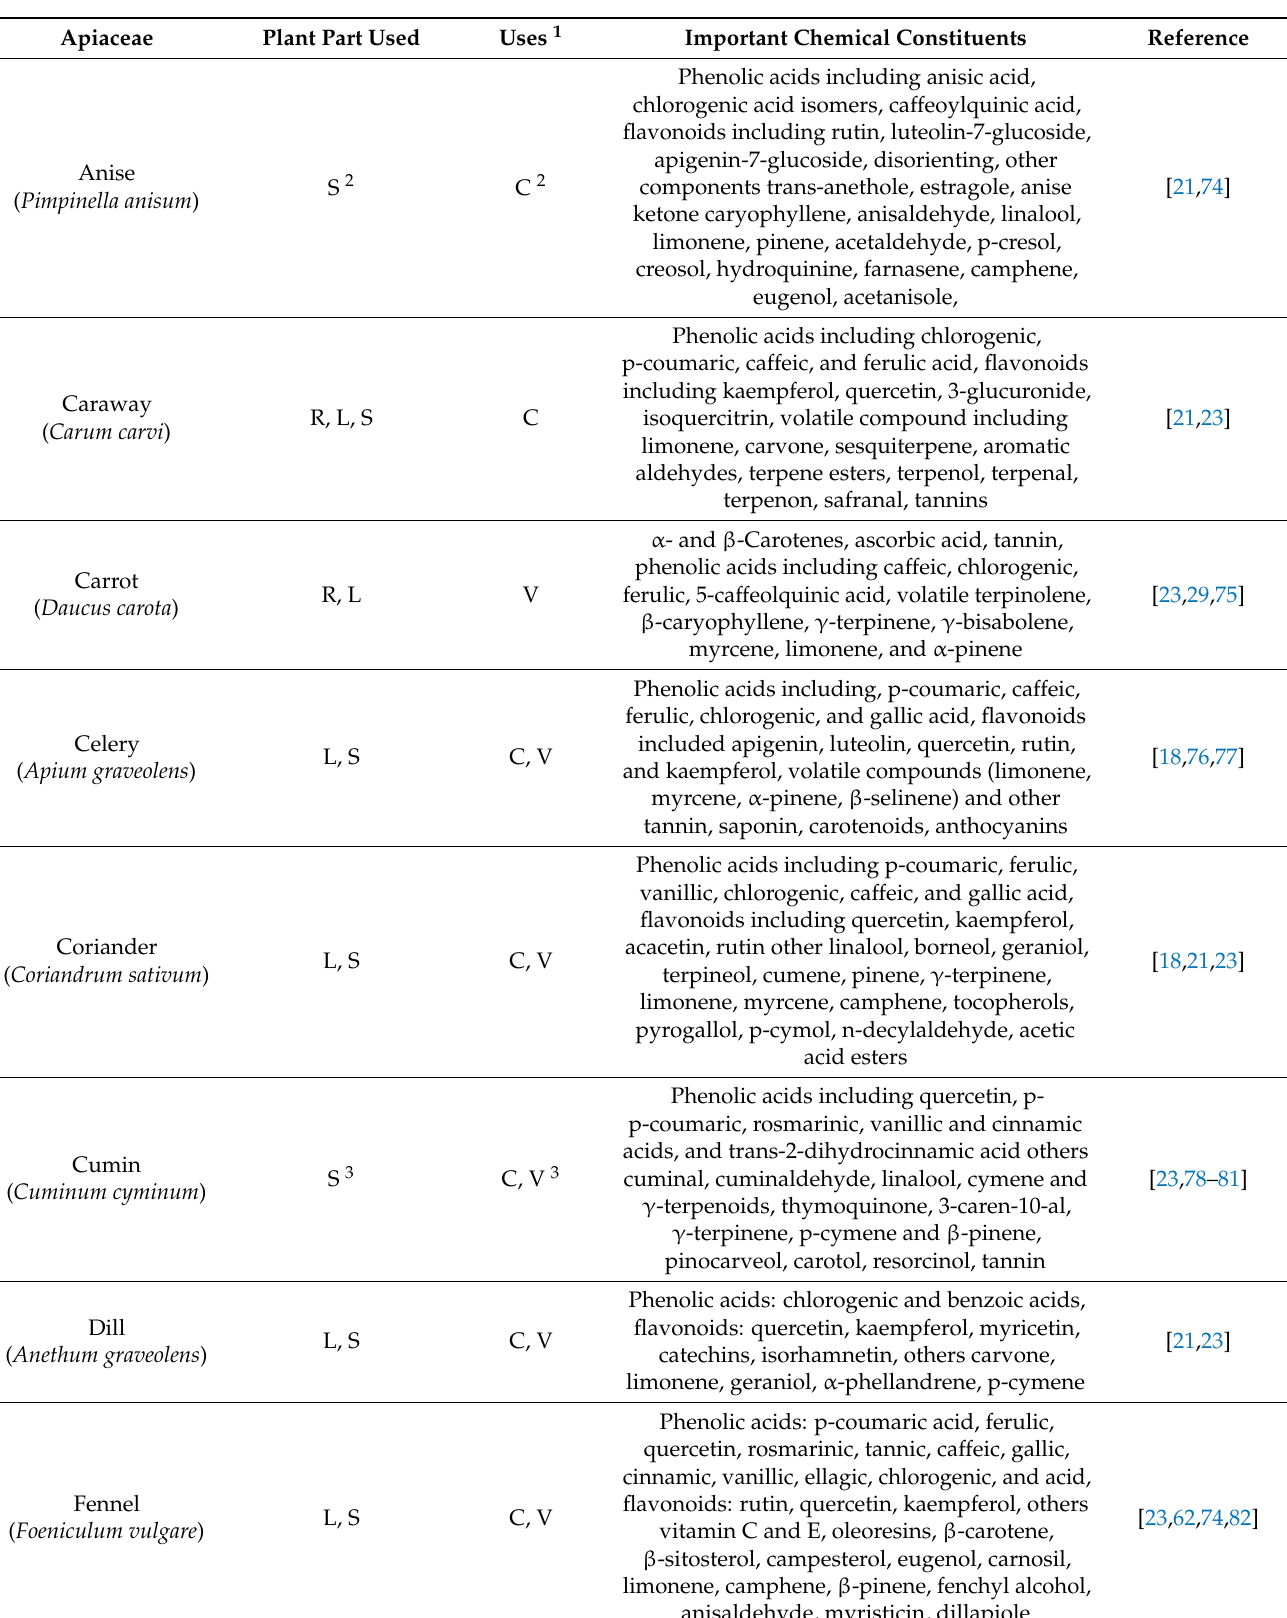
Table 2. Chemical composition of some Apiaceae